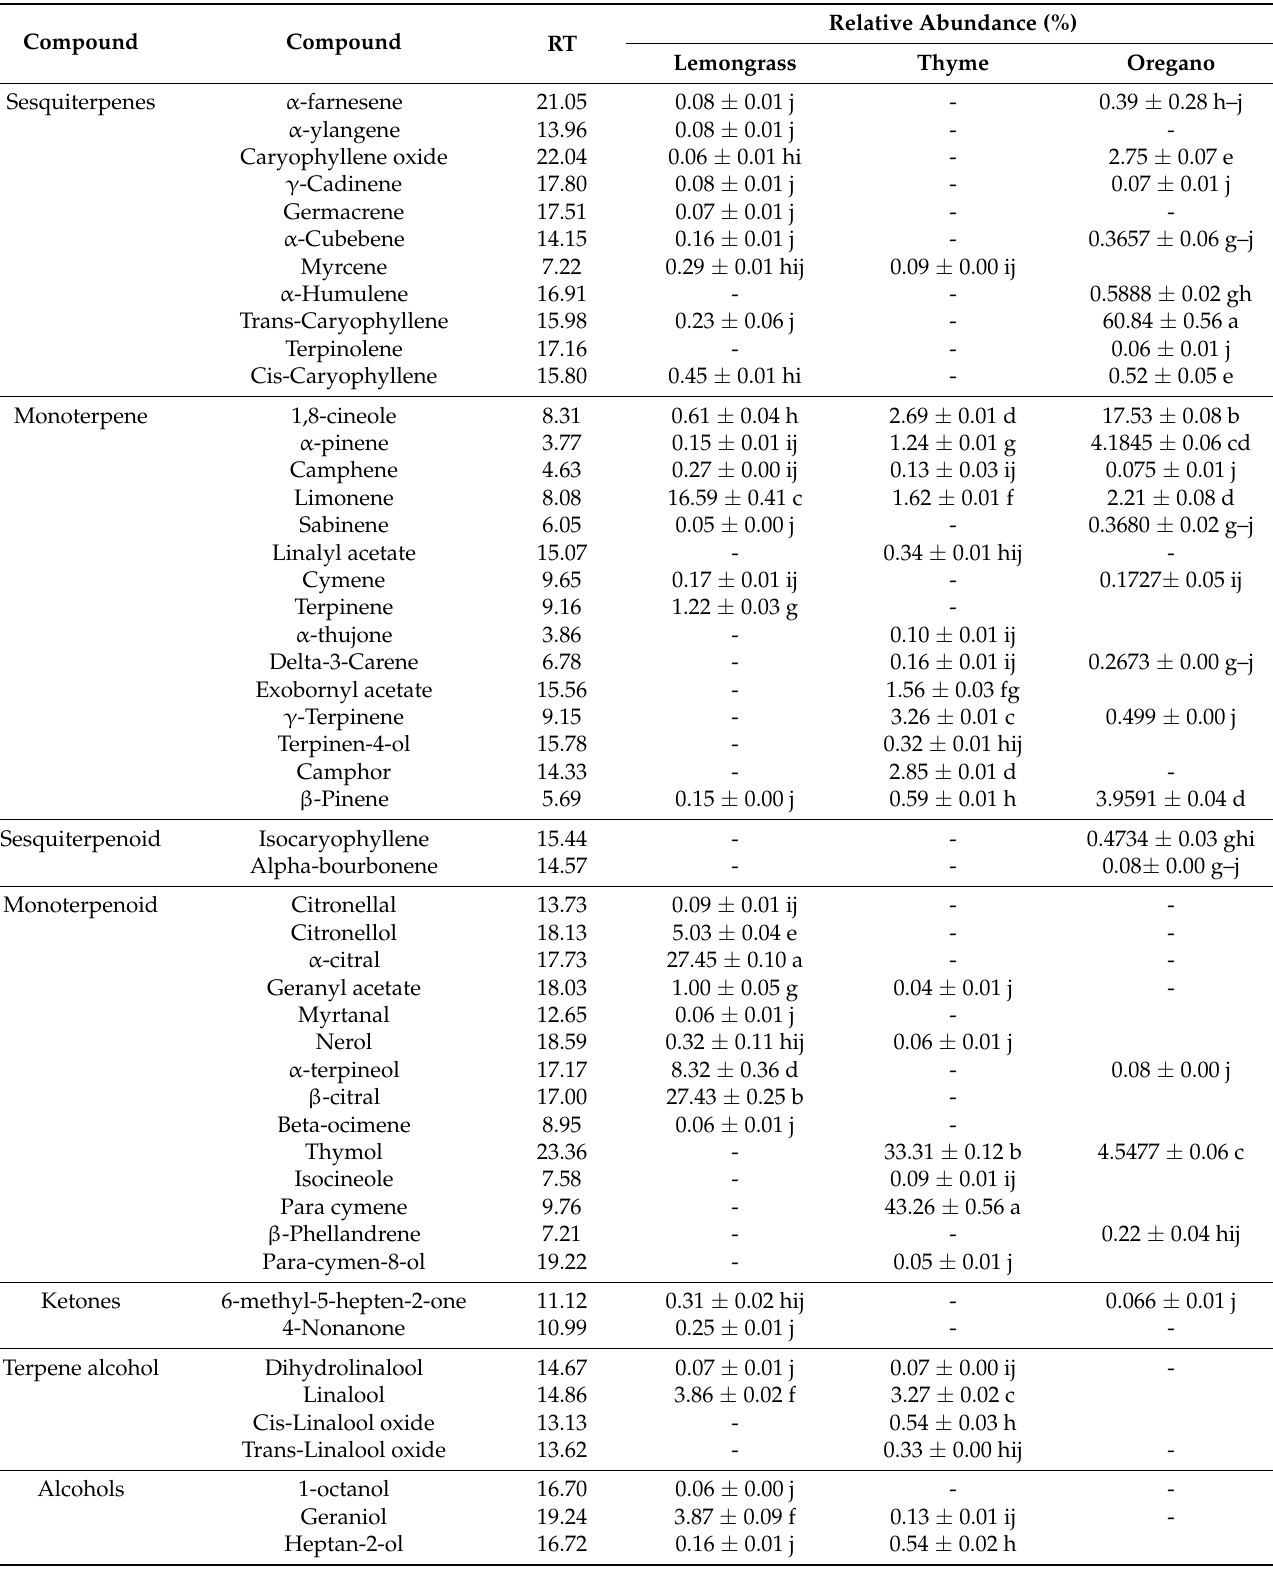
Table 1. The composition and relative abundance (%) of volatile compounds of lemongrass, thyme, and oregano essential oils determined through GC–MS